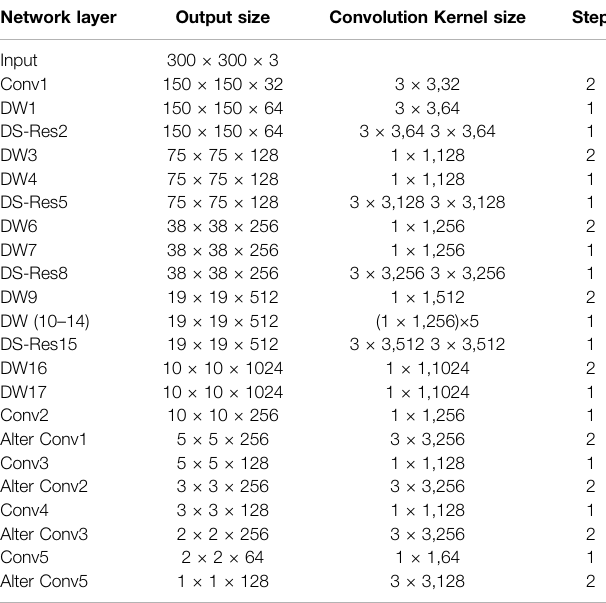
TABLE 2 | The structure of a real-time target detection algorithm based on a lightweight convolutional neural network. Network layer